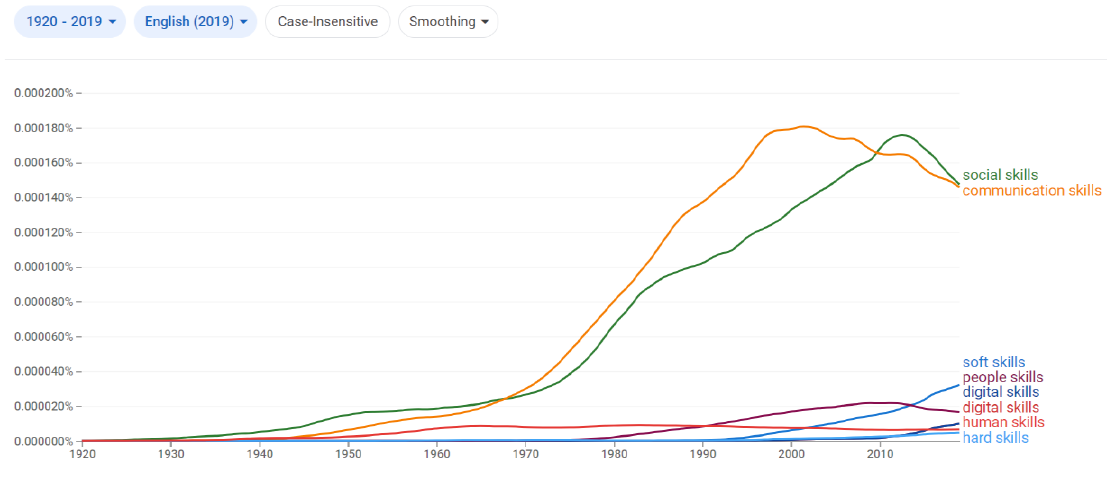
F IGURE 2. T HE OCCURRENCE OF THE “* SKILLS ” PHRASES IN A CORPUS OF E NGLISH - LANGUAGE